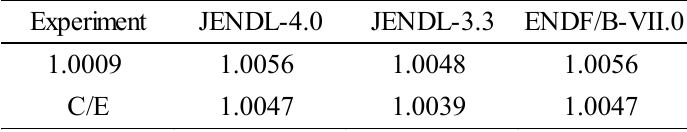
Table IV. Results of numerical analysis for the